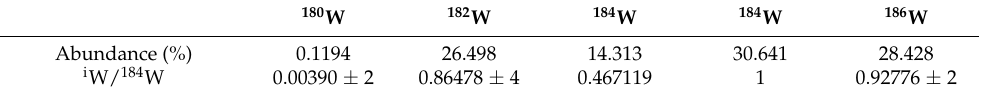
Table 1. The isotopic composition of tungsten in the Earth (modified after [24]). 180 W 182 W 184 W 184 W 186 W Abundance (%) 0.1194 26.498 14.313 30.641 28.428 i W/ 184 W 0.00390 ± 2 0.86478 ± 4 0.467119 1 0.92776 ±